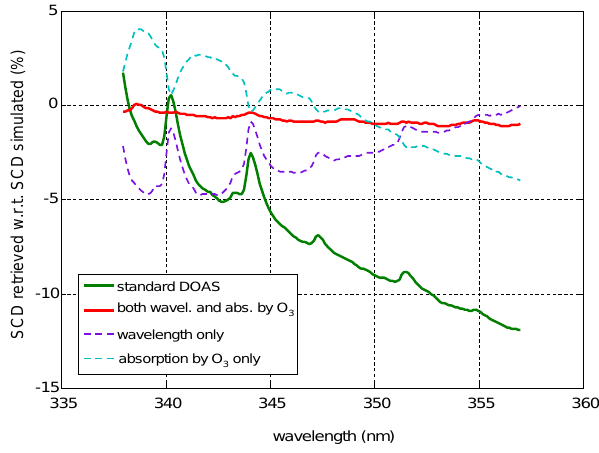
Fig. B1. Relative difference between the retrieved SCDs and the true (simulated) SCDs of ozone at TH=19.8km if different terms describing the variation of SCD of ozone in the fit window are con-